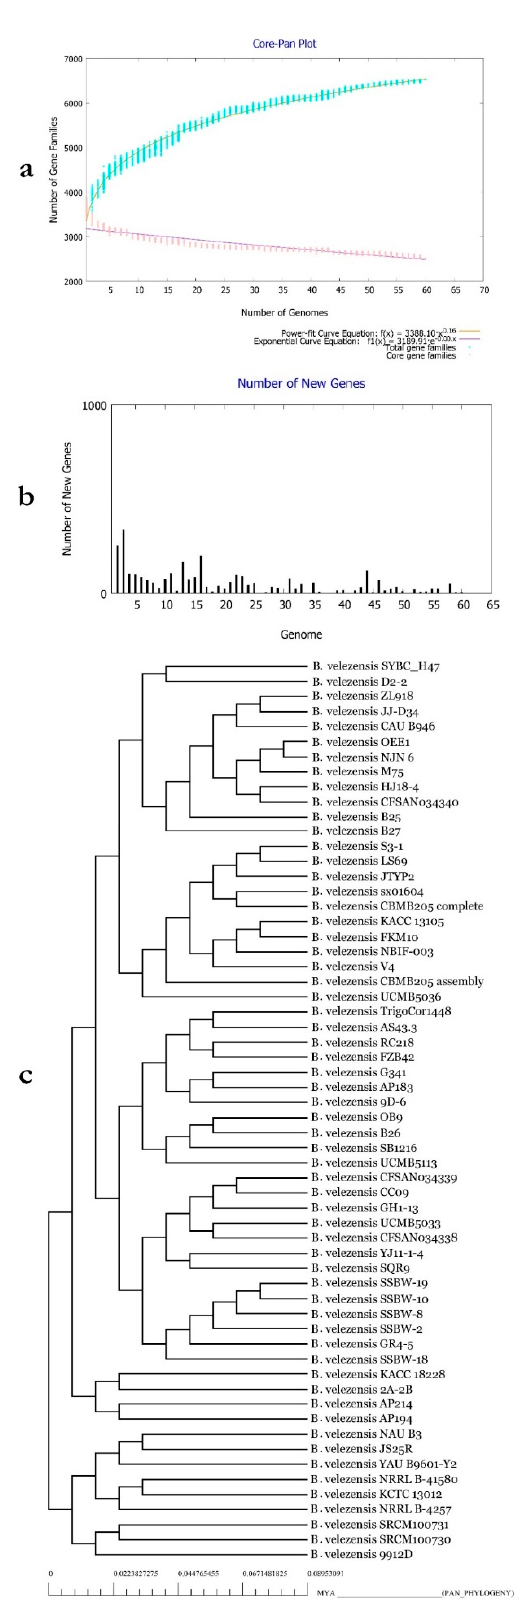
Figure 7. ( a ) Core-Pan genome plot of B. velezensis isolates based on the number of genomes and 526 number of gene families. ( b ) Number of new genes identified in the genomes of the bacteria. ( c ) Tree 527 of Pan-genome related phylogeny of B. velezensis isolates. 528